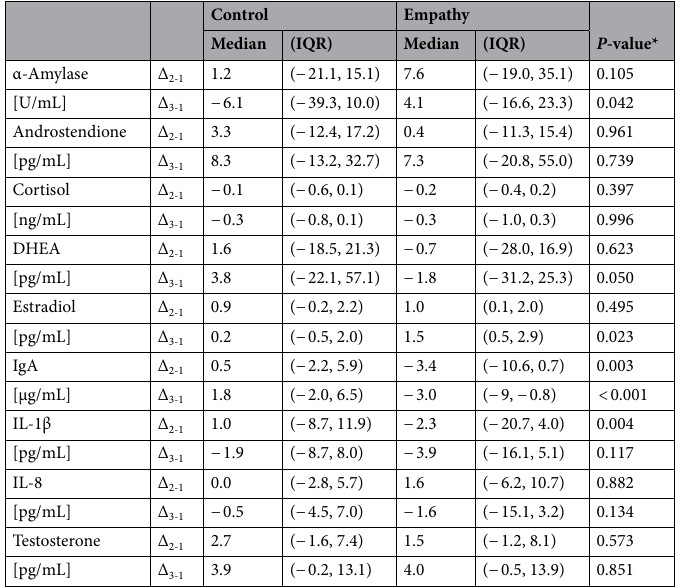
Table 4. Biomarker levels post empathy trigger or control film sequence normalized to time point 1. Δ 2-1 … normalized biomarker level at time point 2 (level time point 2 – level time point 1); Δ 3-1 …normalized